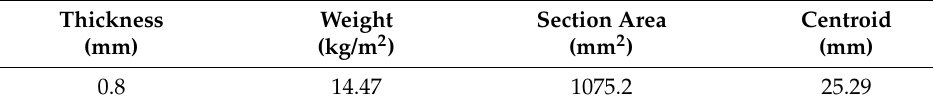
Figure 2. The shape of the deck plate. Table 1. Deck plate sectional